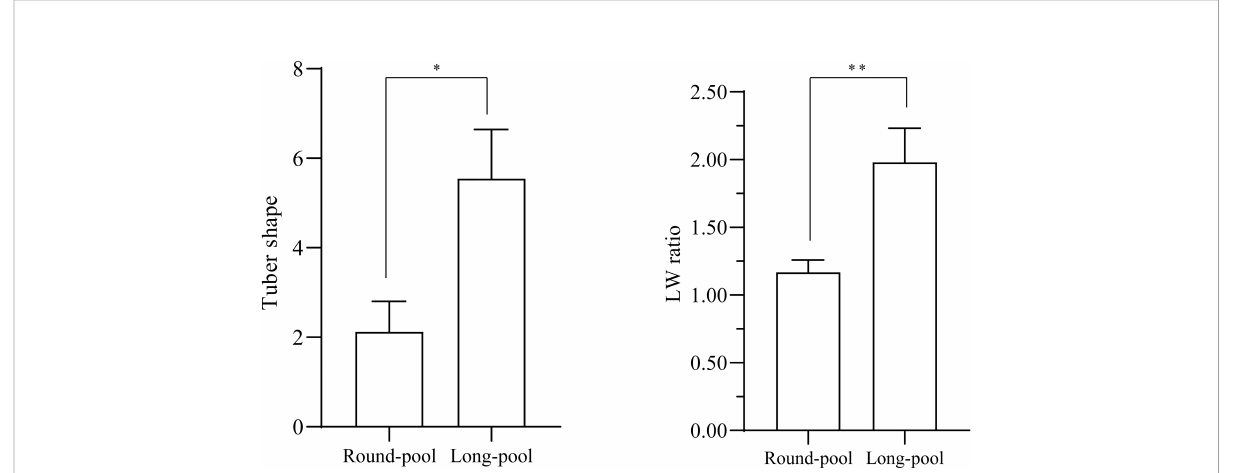
FIGURE 2 The difference analysis of tuber shape performance between Round-pool and Long-pool. (A) The mean value of the tuber shape category in the Round-pool was signi fi cantly lower than in the Long-pool (*p < 0.05 in the t test). (B) The mean value of the LW ratio in the Round-pool was very signi fi cantly lower than in the Long-pool (**p < 0.01 in Student t test).